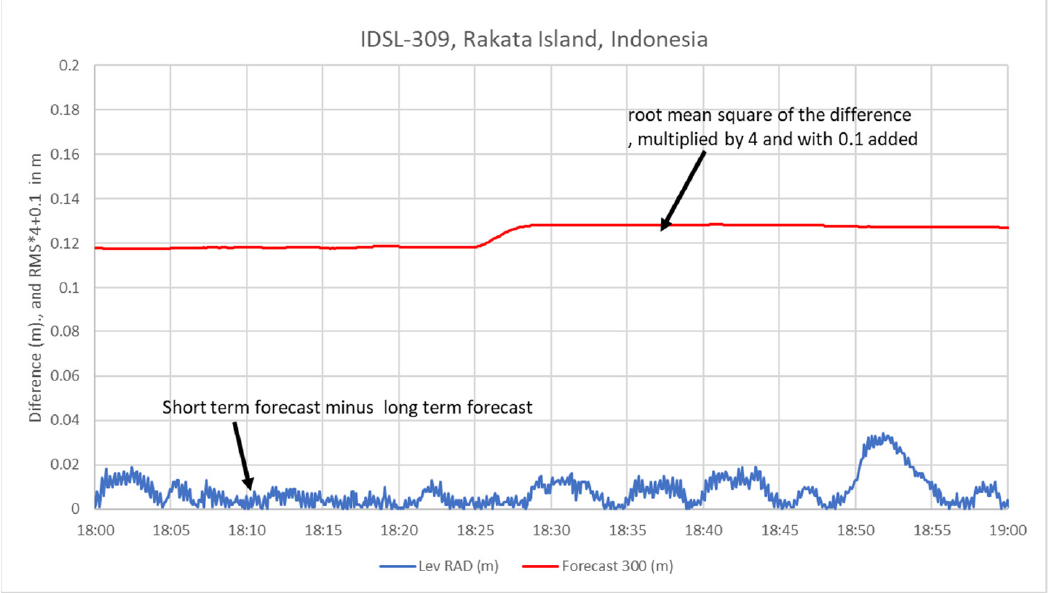
Figure 3. Computed alert parameters from the previous data.